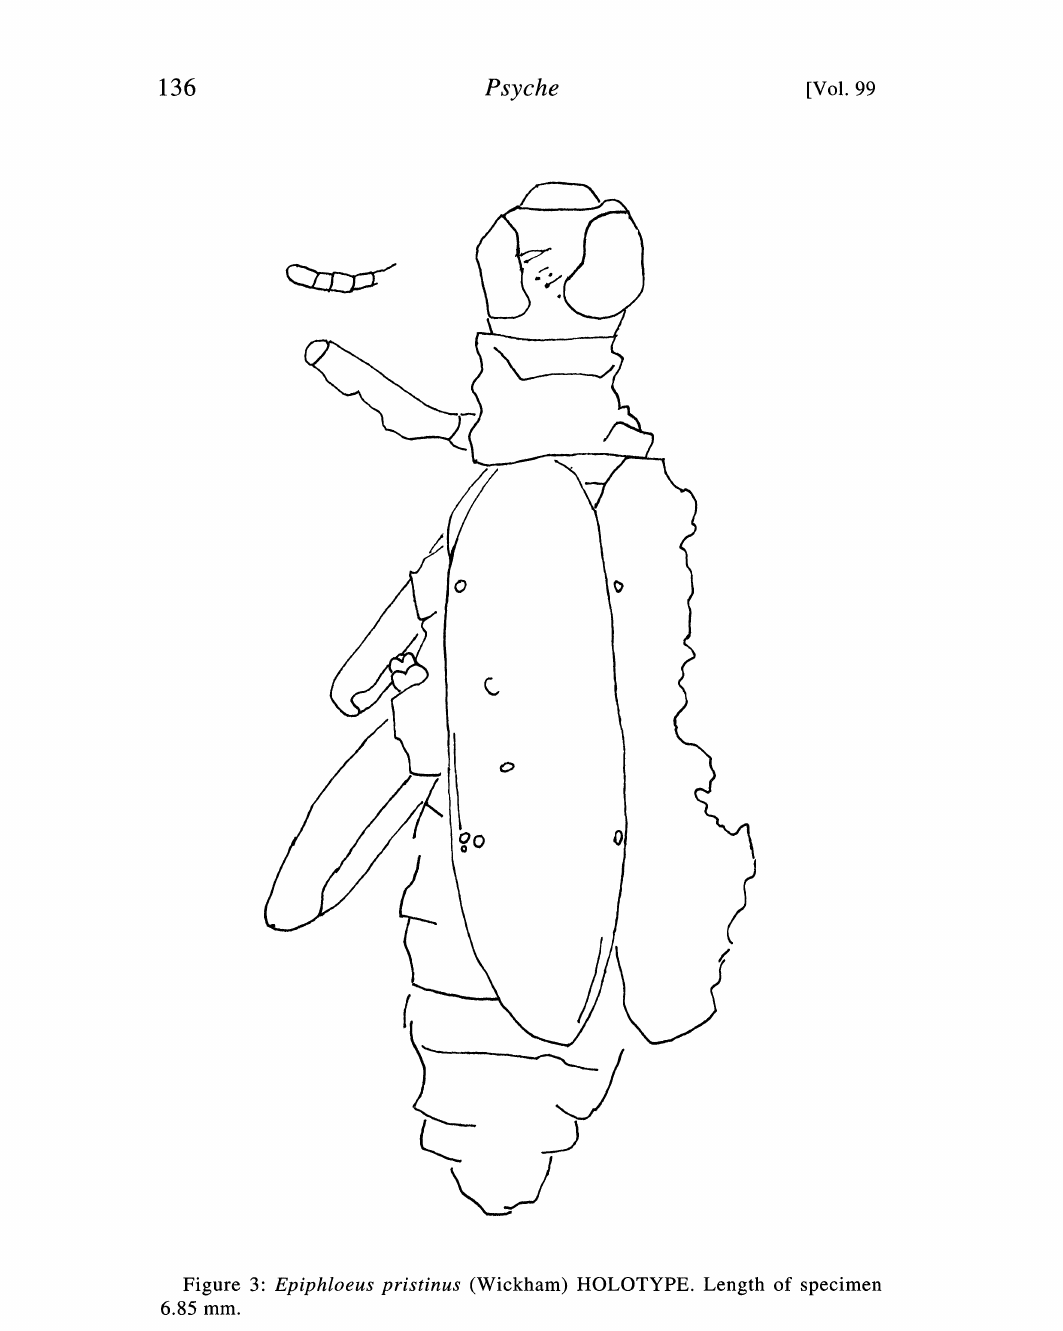
Figure 3" Epiphloeus pristinus (Wickham) HOLOTYPE. Length of specimen 6.85